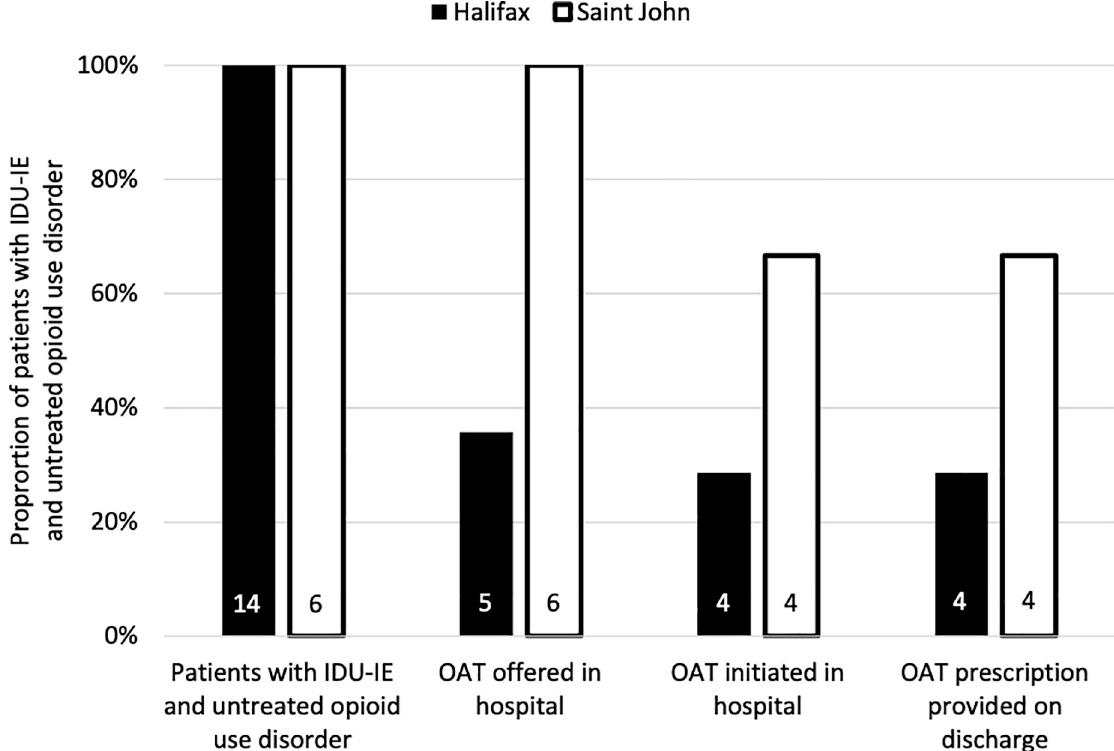
Fig 2. Access to and uptake of opioid agonist treatment during hospitalizations for injection drug use-associated infective endocarditis in Halifax, Nova Scotia (n = 14 hospitalizations), and Saint John, New Brunswick (n = six hospitalizations), October 2015-March 2017. Vertical bars represent proportion of patients with IDU-IE and untreated opioid use disorder at each site; numbers within bars represent the number of patients in each category at each site. IDU-IE: Injection drug use-associated infective endocarditis. OAT: Opioid agonist